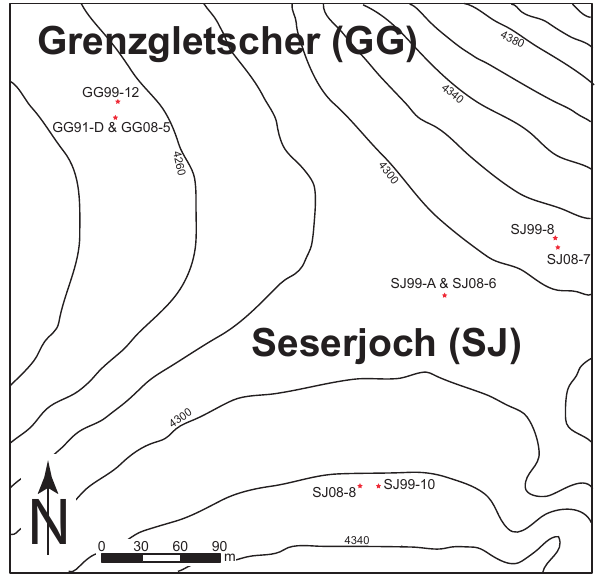
Fig. 3. Location of the borehole sites on Seserjoch and on Grenz-